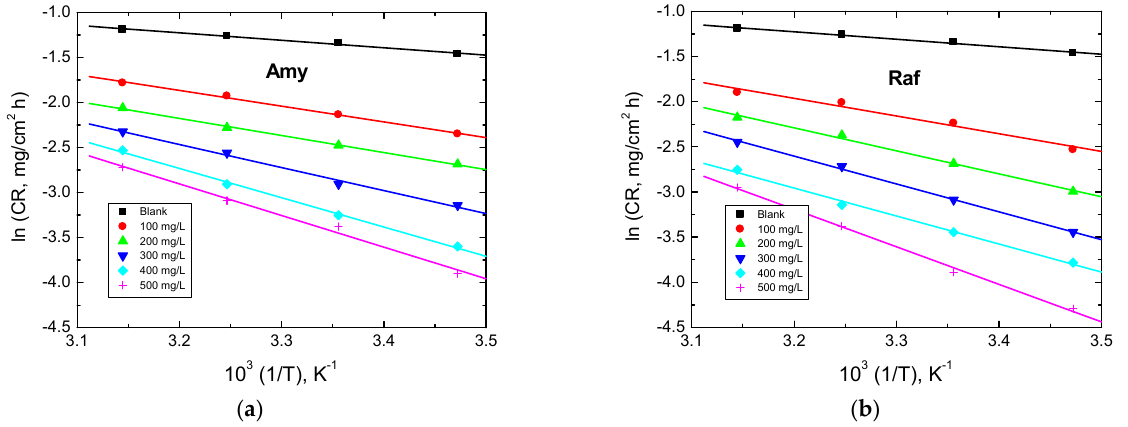
Figure 11. Arrhenius plots for Al corrosion in 0.1 M NaOH medium and with, ( a ) Amygdalin (Amy), and ( b ) Raffinose (Raf). Table 6. Activation parameters for Al corrosion in 0.1 M NaOH medium and with Amy and Raf. Inh. Conc. Inhibitor